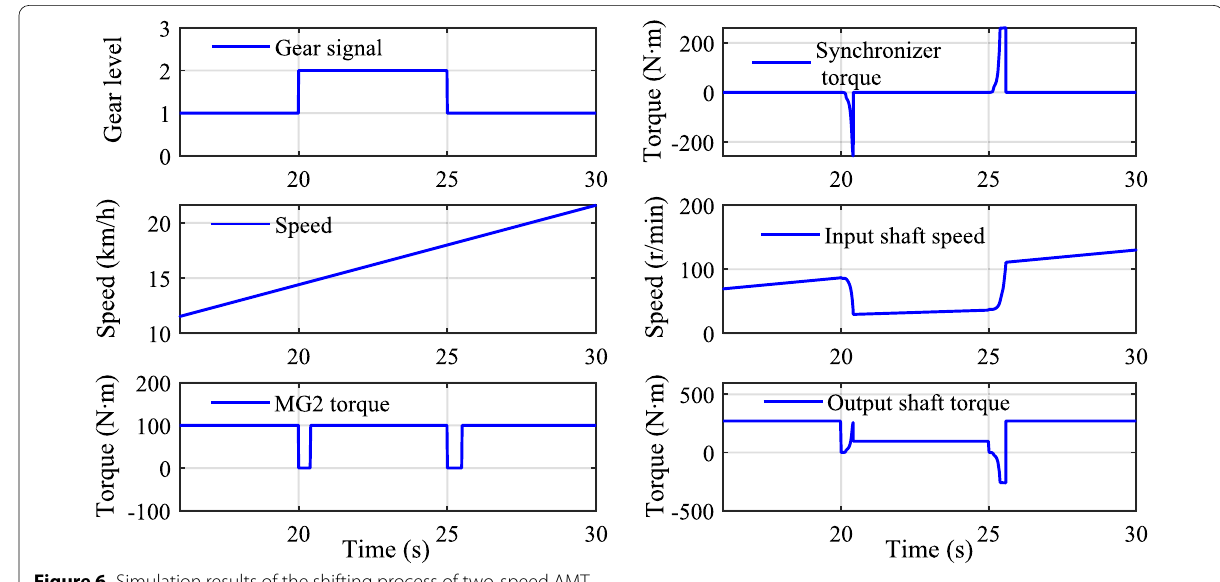
Figure 6 Simulation results of the shifting process of two-speed